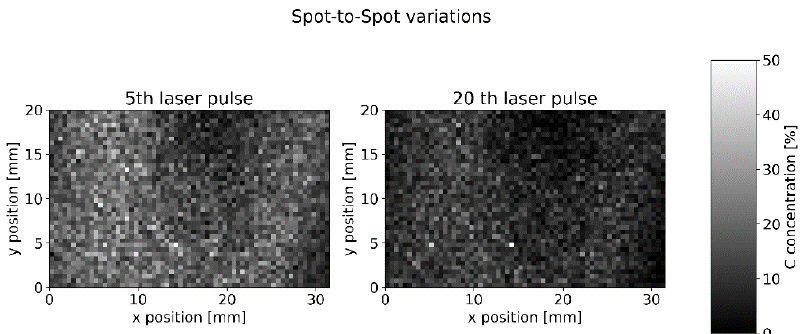
Figure 10. Single ns-LIBS measurement of C concentration (193 nm line) on NMC 111.